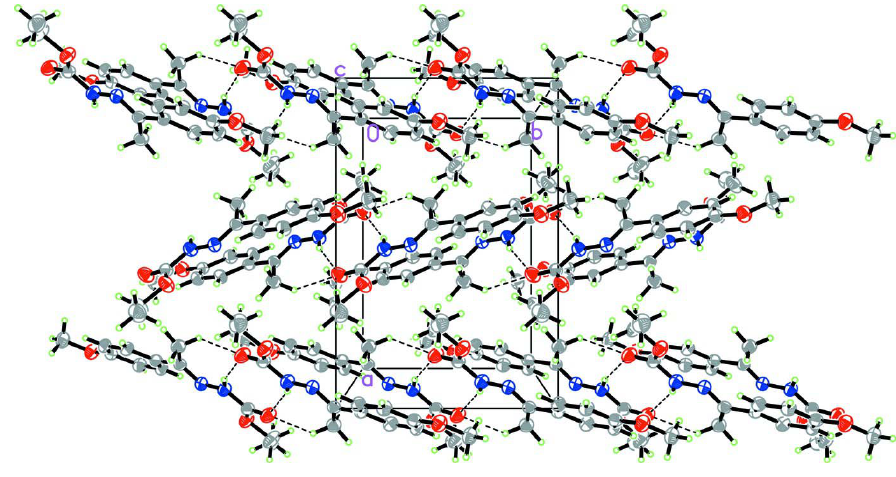
Figure 2 The crystal packing of the title compound, viewed approximately down the c axis. Hydrogen bonds are shown as dashed